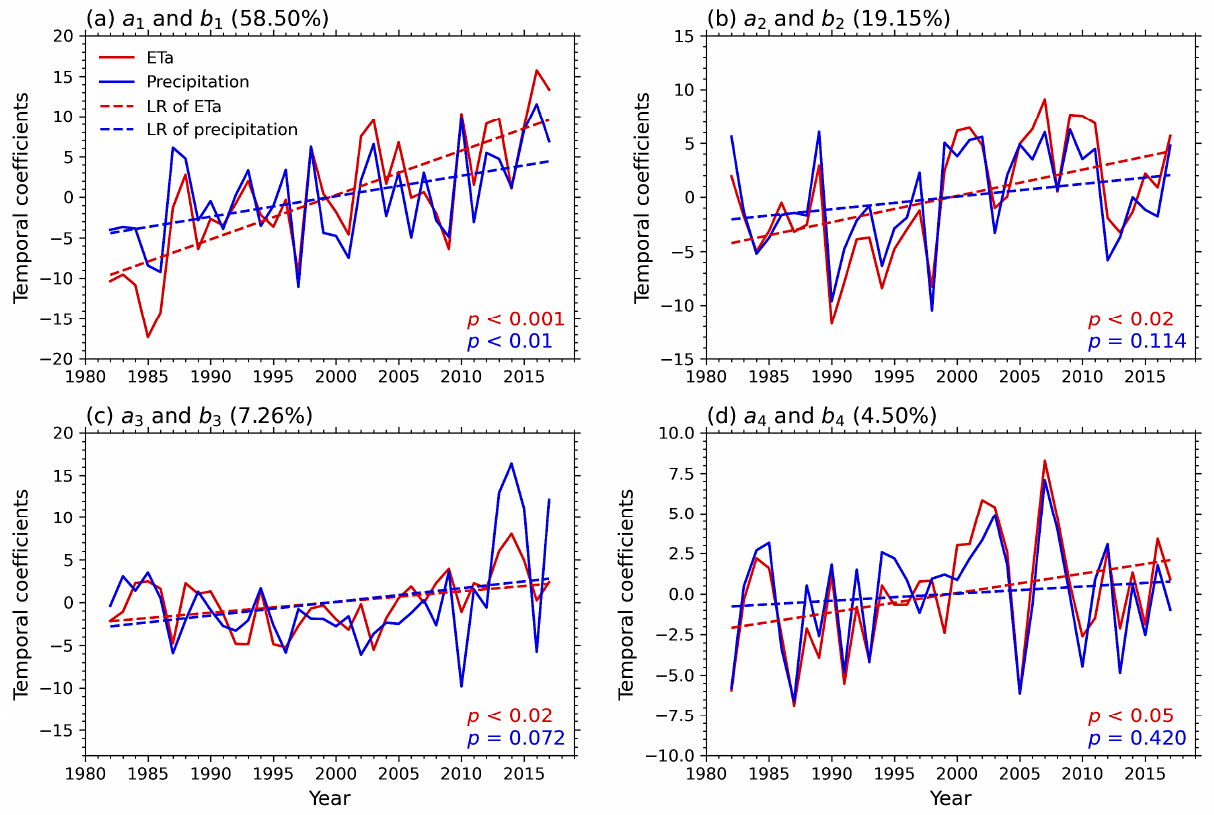
Figure 5. The corresponding temporal coefficients of ETa ( a k , red line) and precipitation ( b k , blue line) for the four leading modes of SVD analysis during 1982–2017. The dotted lines represent the linear regression of the times